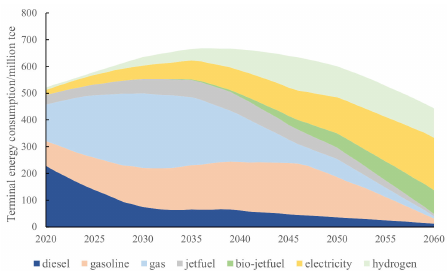
Figure 10. End-use energy consumption in the transport sector in China. End-use energy consumption in the transport sector in China is presented in Figure